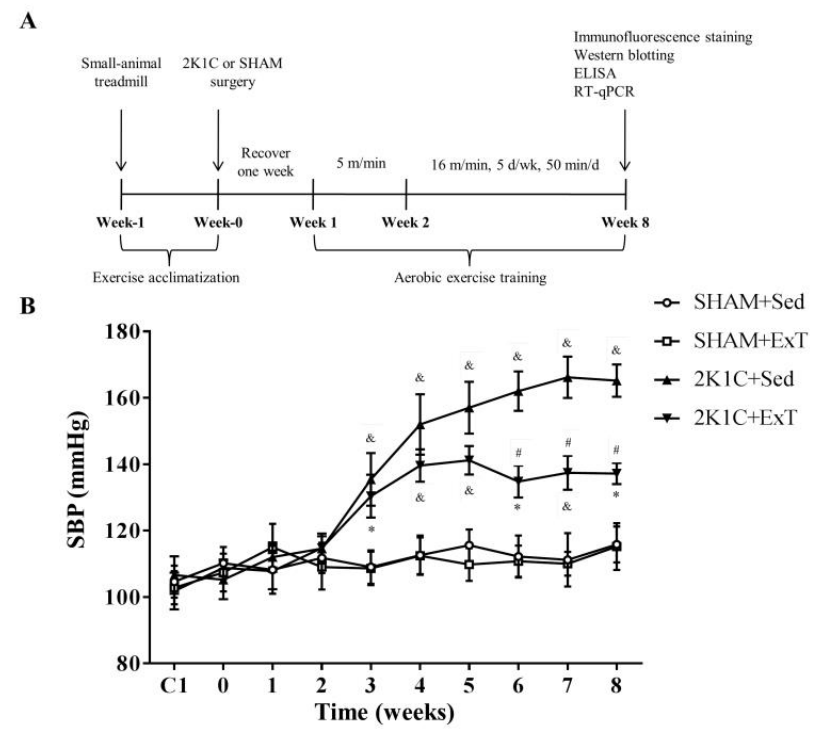
Figure 1. The schematic diagram of blood pressure curves of the four experimental groups. ( A ) Experimental design. ( B ) Aerobic ExT attenuated SBP from the 6th week to the end of the experiment. ( n = 5 rats, * p < 0.05 or & p < 0.01 compared with the SHAM + Sed group or the SHAM + ExT group; # p < 0.01 relatively to 2K1C + Sed group).